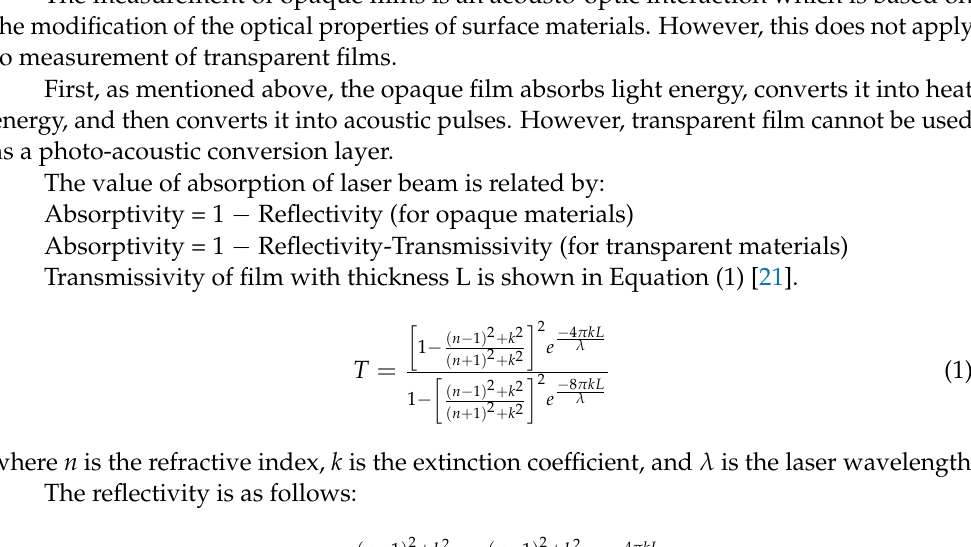
Figure 2. ( a ) Sequence of events in transparent film. ( b ) Typical reflectivity waveform for opaque film. ΔR= δR(t)/R. δR(t) is change amount of reflectivity. R is origin reflectivity. ( c ) Typical reflectivity waveform for transparent film on thermal background.